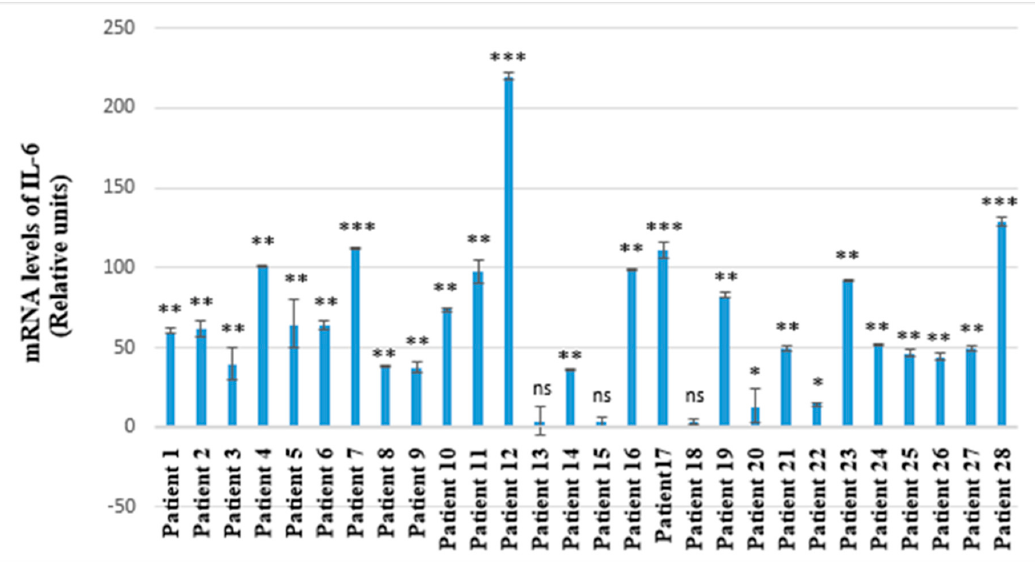
Figure 4. IL-6 mRNA levels in saliva of 28 children with diagnosed pyelonephritis. Expression levels are presented in relative units ± SEM versus human β -actin as endogenous control. * p < 0.05 versus control group; ** p < 0.01 versus control group; *** p < 0.001 versus control group; ns—not significant.